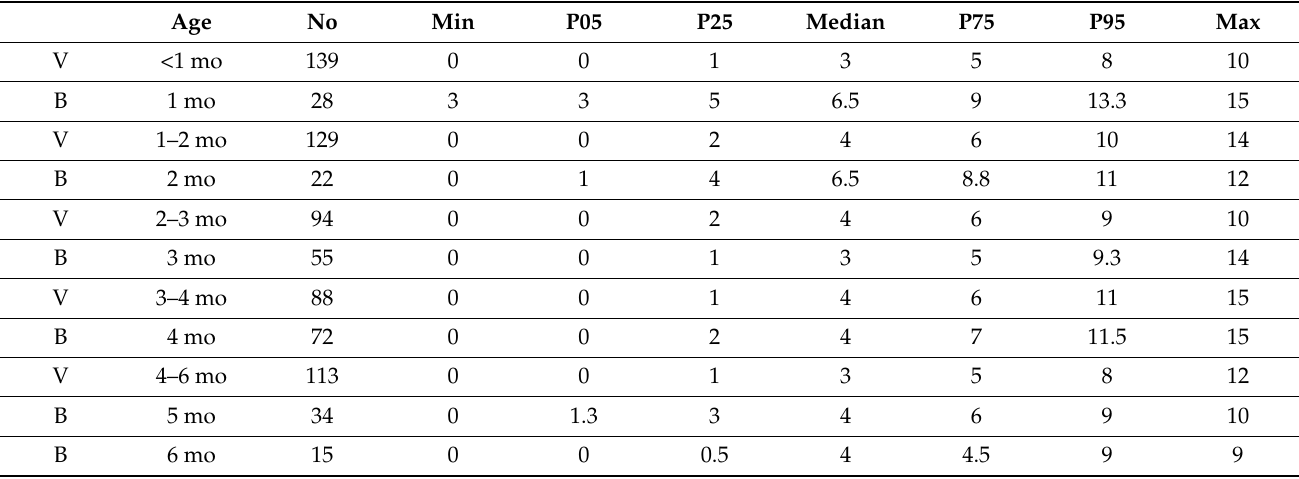
Table 4. Age specific CoMiSS in presumed healthy infants.